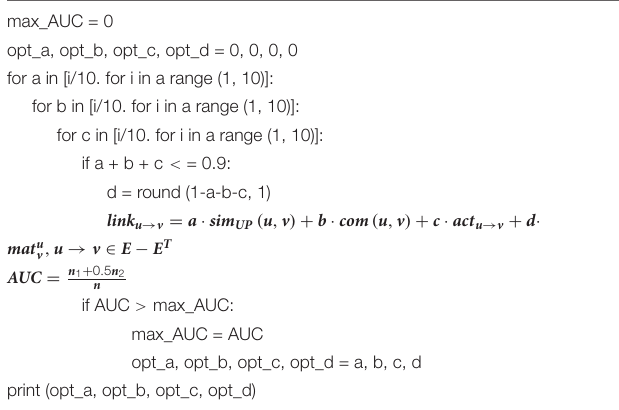
Algorithm 2 lists the schematic code of the weight